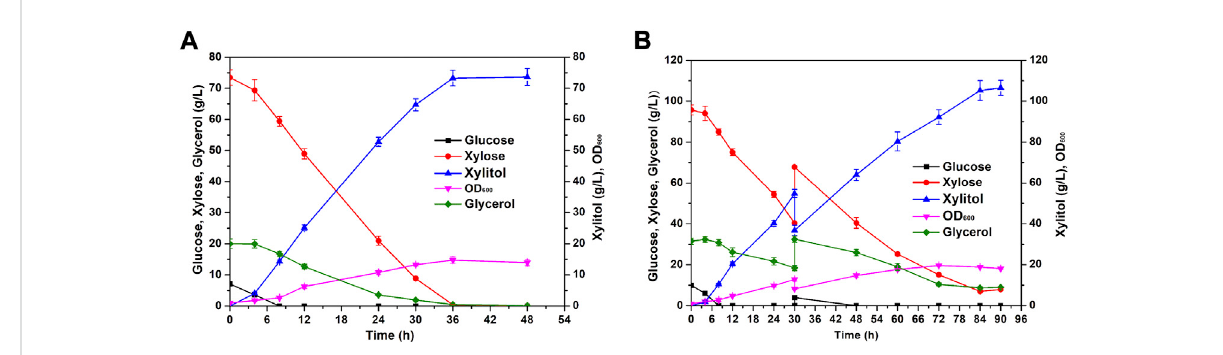
FIGURE 6 High-concentration xylitol produced from condensed corncob hydrolysate. (A) YZJQ016 fermented with concentrated corncob hydrolysate and 20 g/L glycerol in a fermenter at 42 ° C. (B) YZJQ016 fermented with concentrated corncob hydrolysate and 31.53 g/L glycerol for fed-batch at 42 ° C.